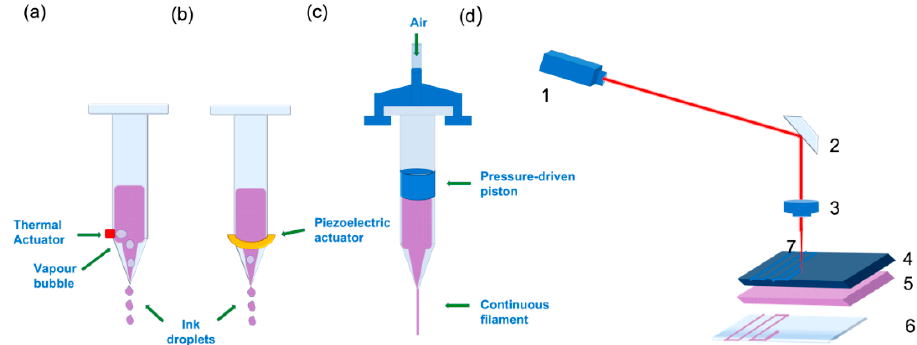
Figure 1. Schematic image of different bioprinting approaches: Two different types of inkjet droplet- based bioprinting approaches: ( a ) Thermal: The droplets are generated via a heating device that produces vapour in the thermal inkjet bioprinting approach. The bioink is ejected by deformation of the liquid cavity caused by the thermal action. ( b ) Piezoelectric inkjet bioprinting: the device responsible for generating the desired droplets is a piezoelectric actuator, also marked with a green arrow. In this case, the piezoelectric device increases its size, deforming the liquid cavity, and generates a droplet. In both cases, the cartridge is loaded with bio ink. ( c ) Pressure-assisted bioprinting. The green arrow is showing air entrance; the compressed air inside the cartridge forces the piston down onto the loaded bioink, and the movement of the piston extrudes the bioink through the nozzle in a continuous filament. ( d ) Laser-induced forwards transfer (LIFT) technique representation. (1) Laser source or diode. (2) Mirror. (3) Focusing lens. (4) Surface receiving laser irradiation. (5) Bioink containing cells. (6) Receiving substrate. (7) Laser beam. When (4) absorbs the laser beam, a vapour bubble is induced in (5), and a droplet encapsulating bioink and cells is created.